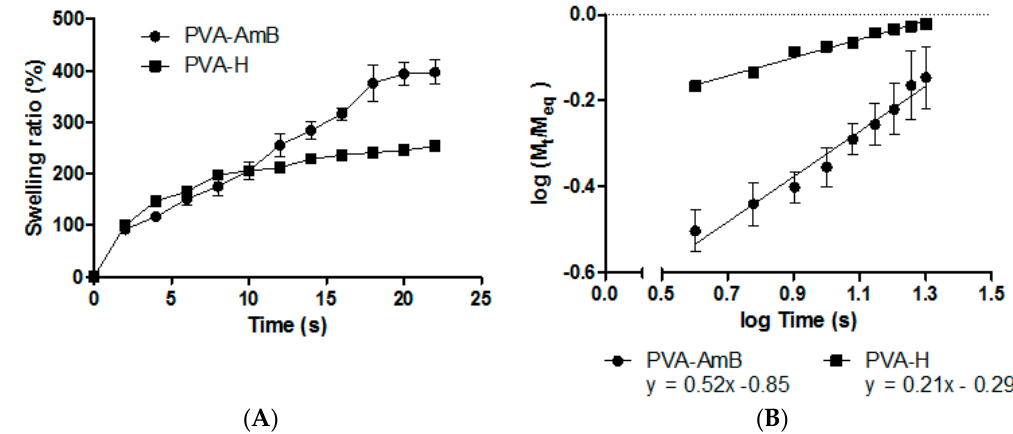
Figure 2. ( A ) Swelling degree of poly(vinyl-alcohol) (PVA)–H and PVA–AmB. ( B ) Log-log plot from which were calculated the diffusional exponent ( n ) and the diffusion constant ( k ) of PVA–H and PVA– AmB in phosphate saline